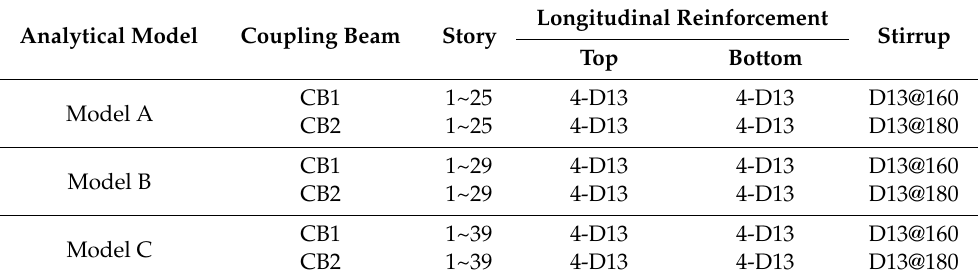
Table 6. Reinforcement of coupling beams.